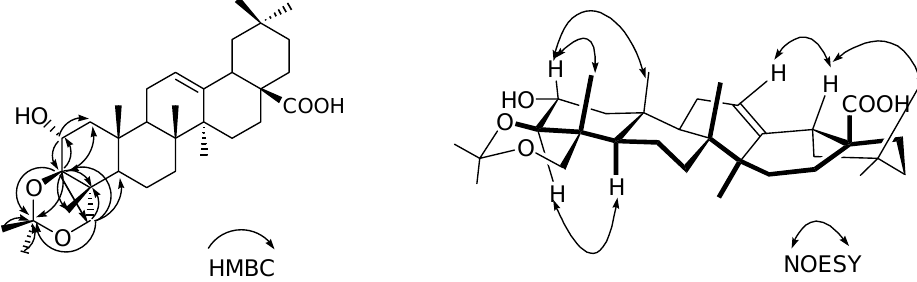
Figure 2. The key HMBC(H → C)and NOESY(H → H)correlations of 1 .